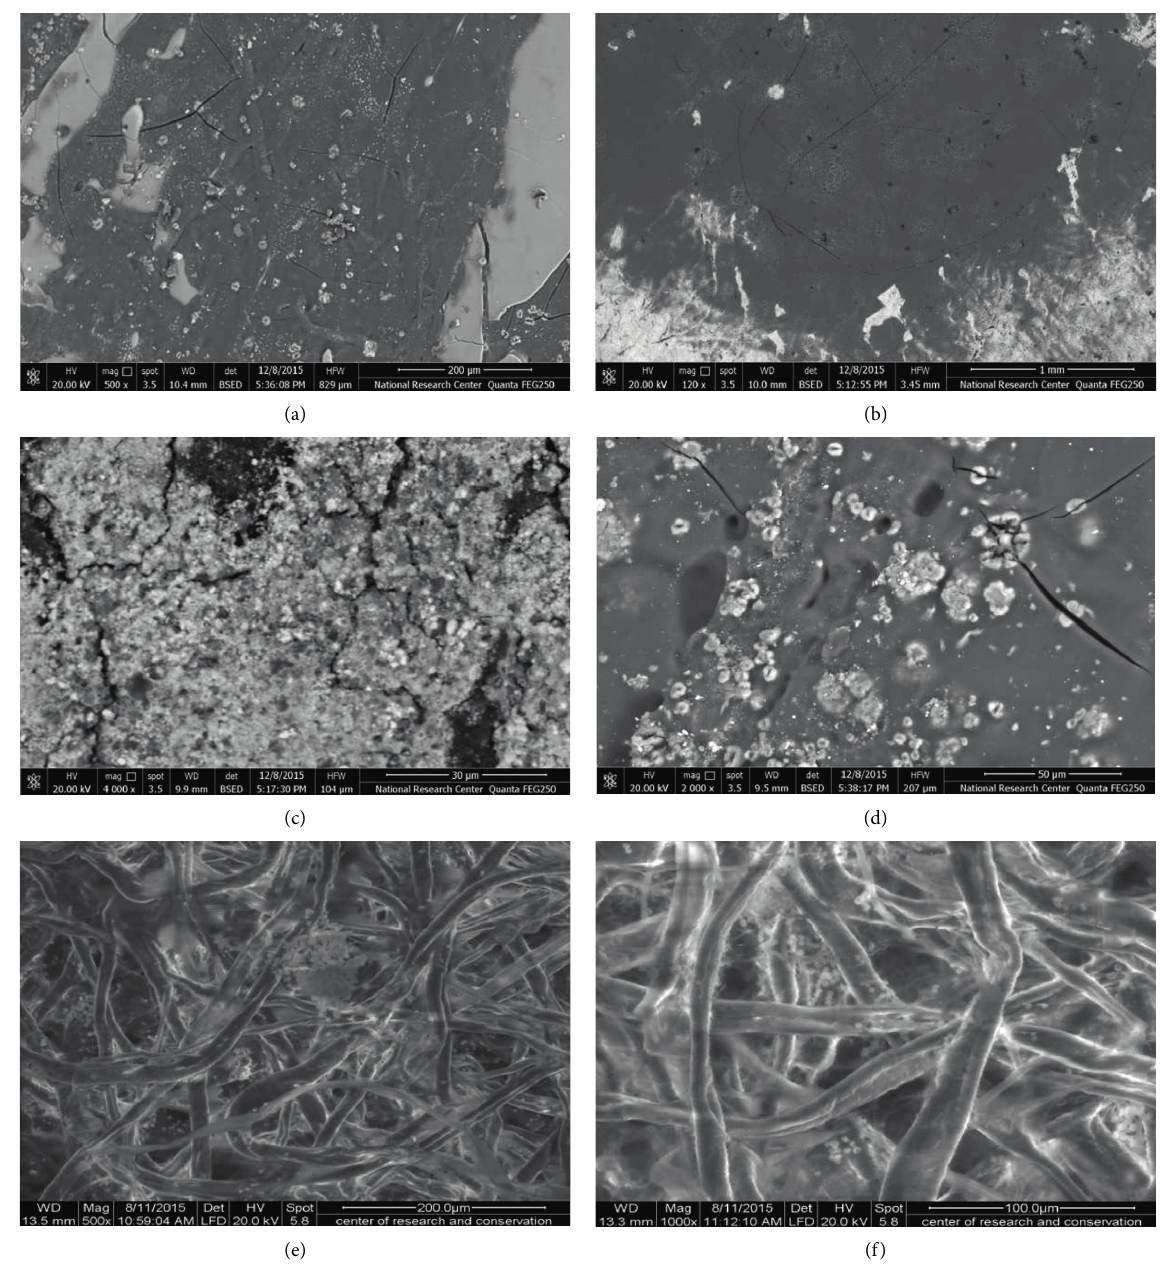
Figure 9: The cracks in the printing ink layer of red stamp at 500X magnification power (a). The printing ink layer at 120X magnification (b). The growth of fungi on the paper fibers at 4000X magnification (c). The cracking of the color layer and the growth of fungi on the printing ink at 2000X magnification (d). The erosion of the stamp fibers showing their attack by fungi at 500X magnification (e). The shape of the stamp fiber paper, which shows that it is made of cotton pulp at a magnification of 1000X